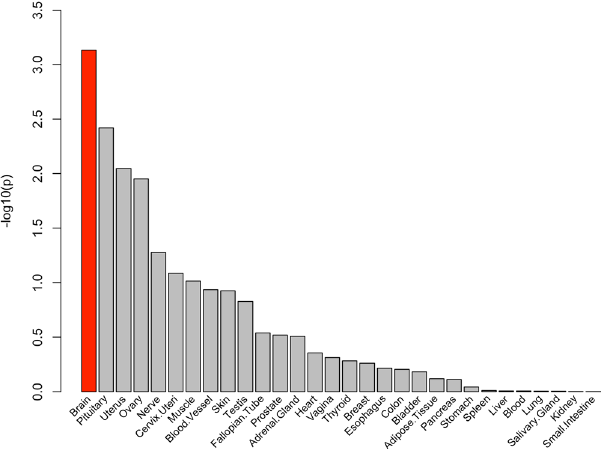
Figure 3. Enrichment of tissue-expression for grip strength loci in 30 tissue types.